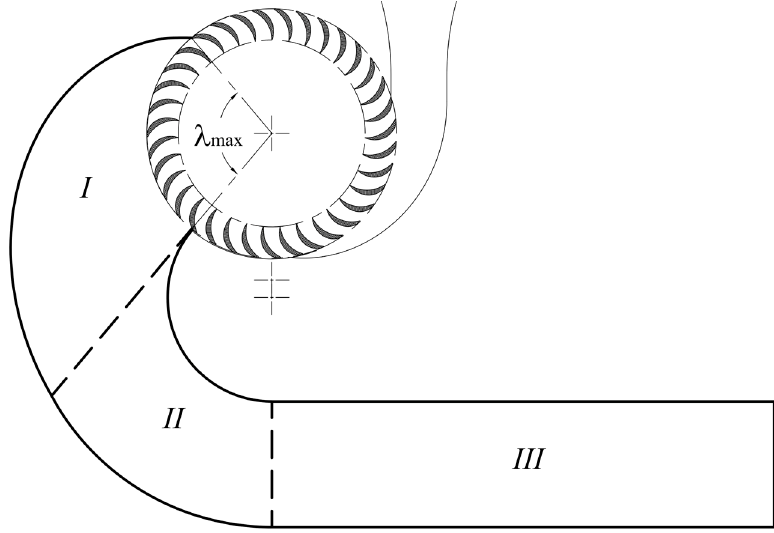
Figure 5. Section view of the diffuser, composed of parts marked I , II and III .